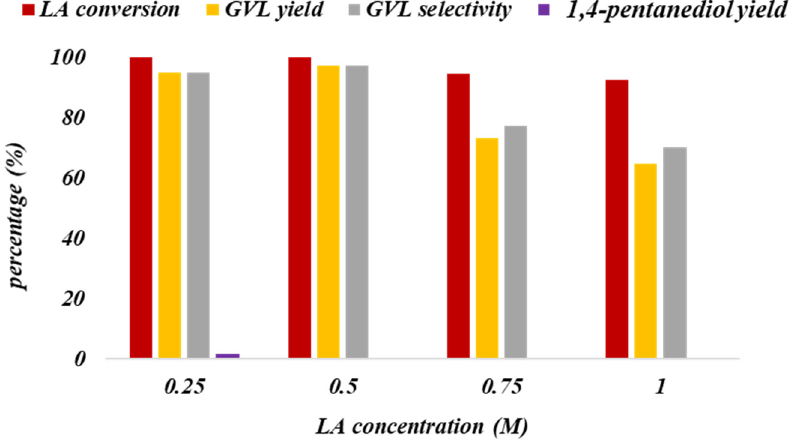
Figure 7. LA concentration effect over Ru/C H Zn cotton catalyst. Reaction conditions: 100 °C, 120 min, 10 mL of H 2 O, 10 mg of catalyst, 10 bars P H2 .